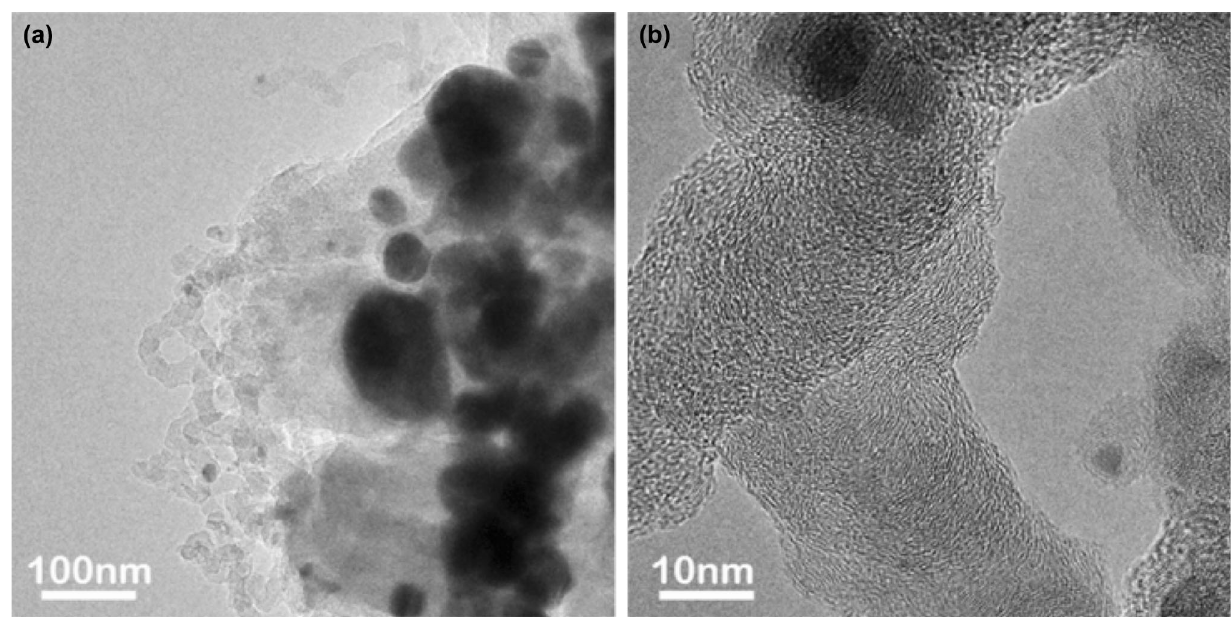
Fig. 3 Structural characterization by TEM: a lower magnification showing aggregates and fibrous features, b HRTEM showing the disordered nanocrystalline